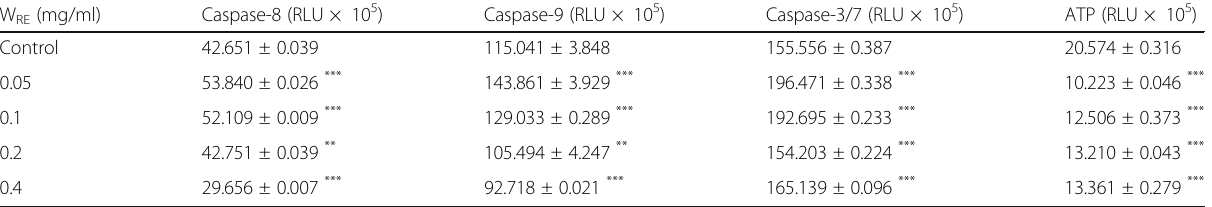
Table 4 Modulation of caspase (-8, -9, -3/7) activity and ATP levels in LPS stimulated and 72 h W RE treated PBMC ’ s W RE